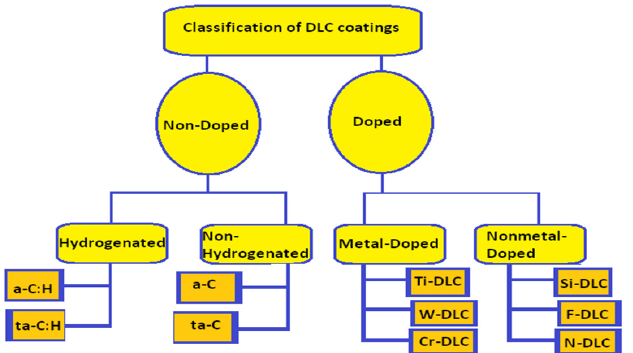
Figure 1. The general classification of DLC